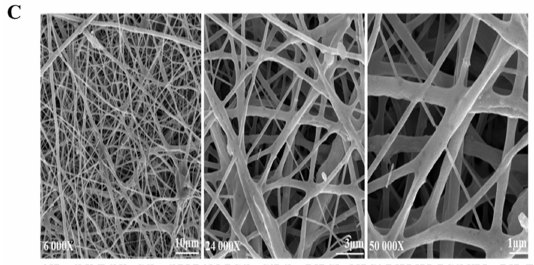
Figure 1. Morphology and analyses (quantitative and qualitative) of IBU-PCL electrospun fibrous scaffolds. In vitro IBU release profile ( A ) and localization of IBU ( B ) within PCL electrospun fibers. 98% of IBU was released from PCL electrospun fibers during the first two hours in PBS. Analysis was determined by UV spectroscopy and transmission electron microscopy observation (TEM). The scale bar of the TEM images represents 100 and 200 nm. The fiber size distribution was obtained by measuring at least 200 fibers in different scanning electron microscopy (SEM) images ( C ) of the IBU-PCL electrospun fibrous membrane. The fiber solution was constituted by 10% of PCL, 20% of non-commercial hydroxyapatite (HAnC), 10% of IBU and 10% of polyvinyl acetate (PVAc) ( w / w ), and the fiber diameter was of 374 nm. The scale bar of the SEM images represents 10, 3 and 1 µ m.